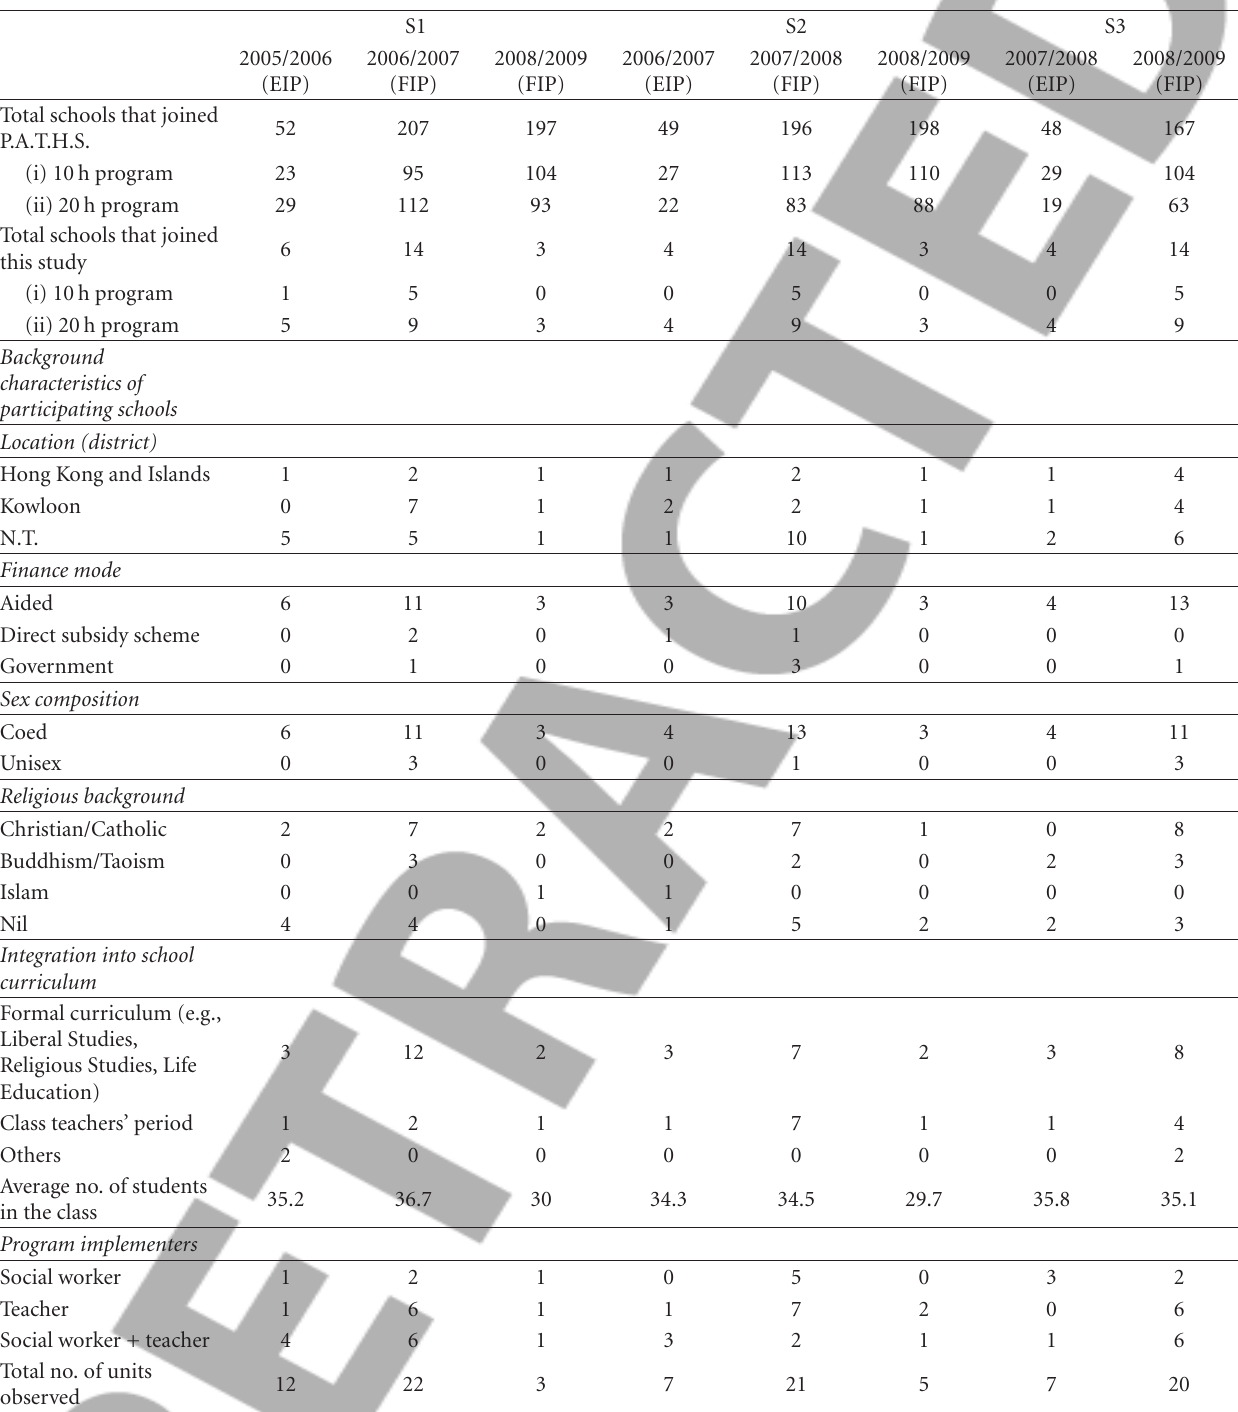
Table 1: Descriptive profile of participating schools from 2005 to